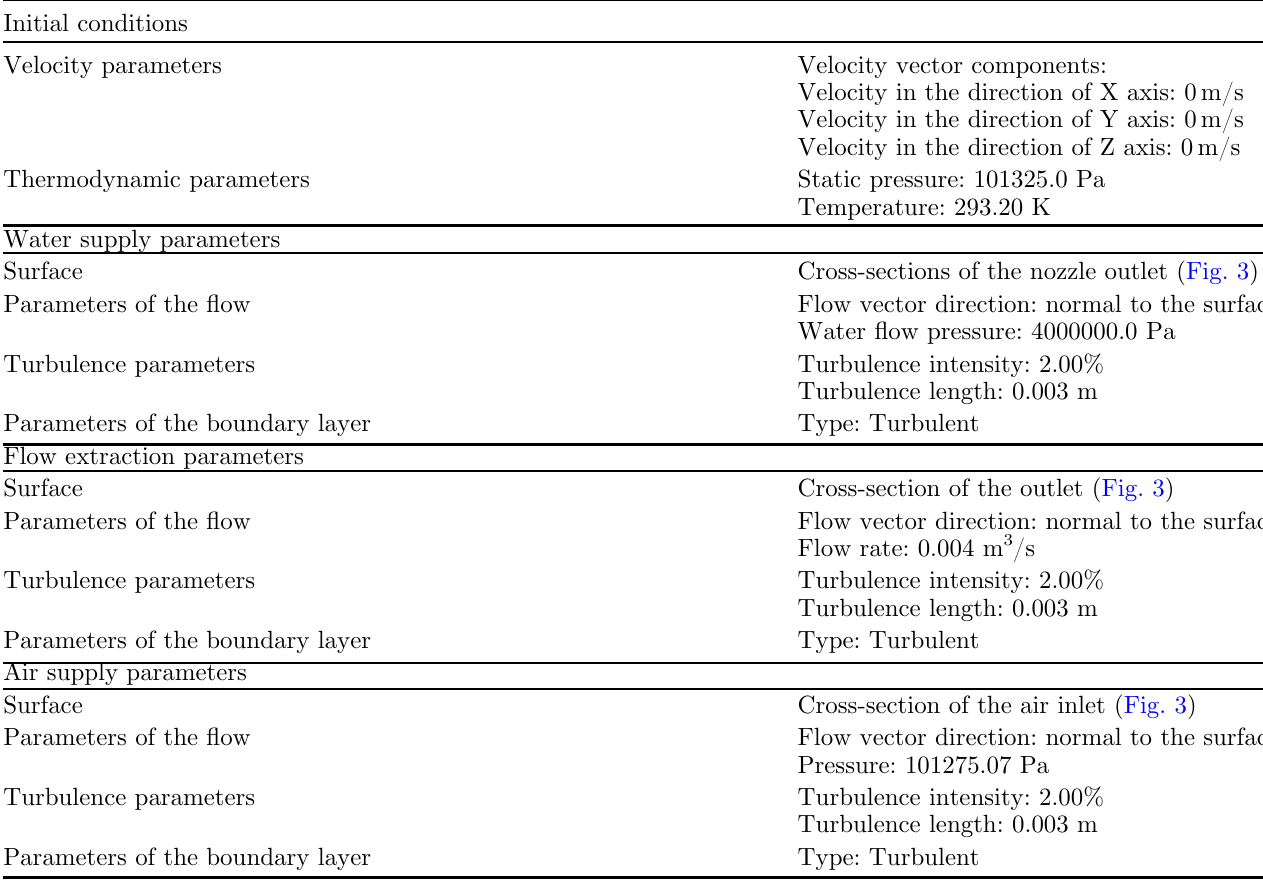
Table 1. Initial and boundary conditions used in the numerical simulation of cavitation process.